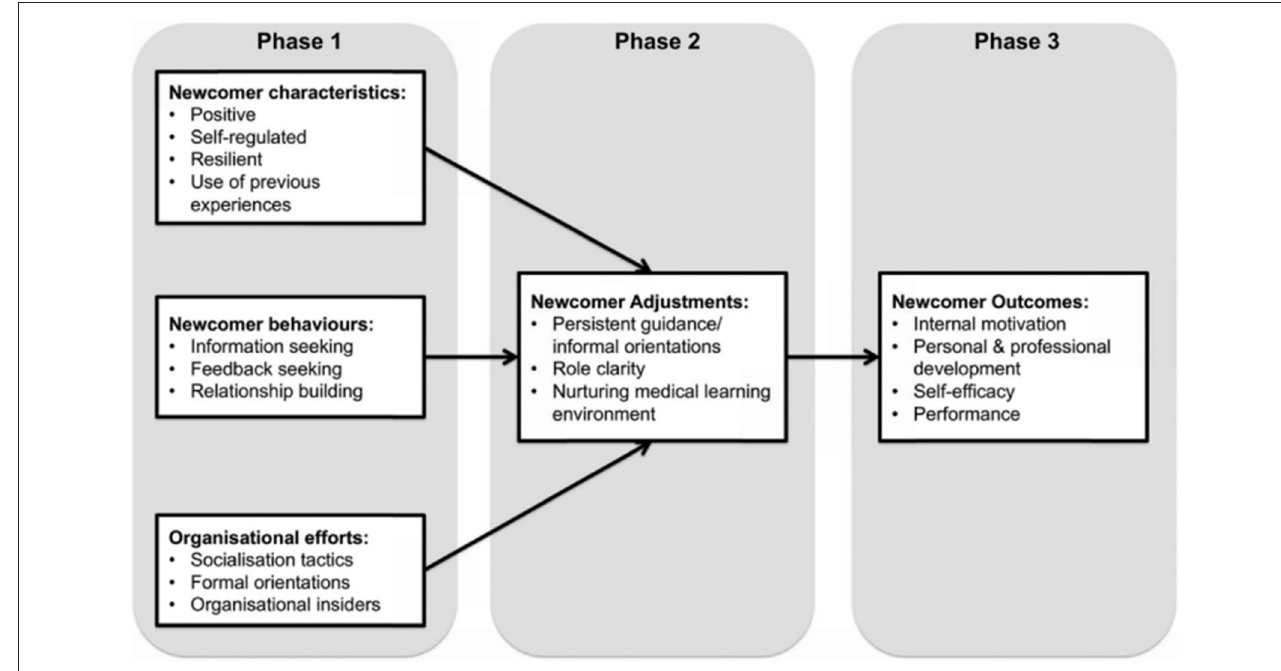
FIGURE 1 | The organizational socialization theory by Bauer and Erdogan (12) modified by Atherley et al. (13). (Used by permission of the